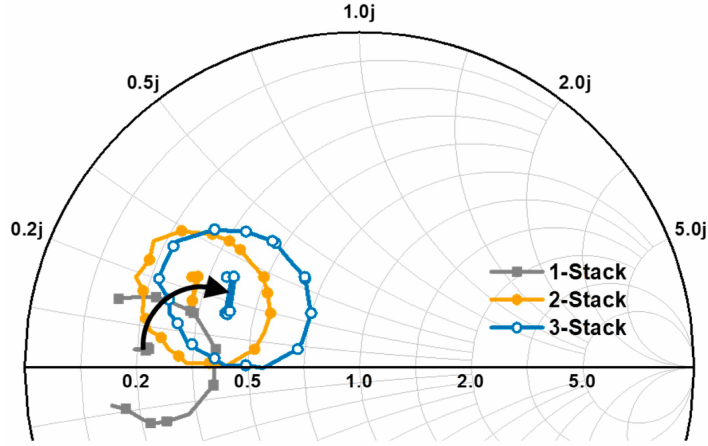
Figure 2. Load-pull simulation results of stacked power